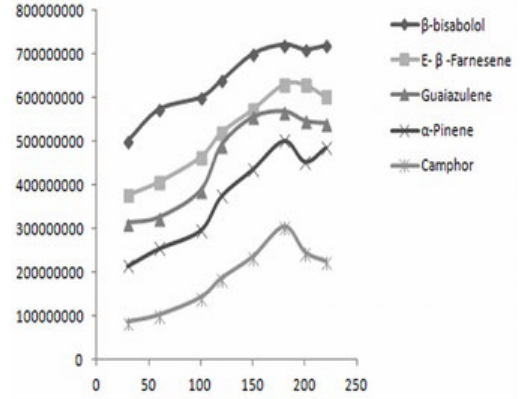
Fig. 5. Effect of desorption temperatures on the extraction efficiency. (X= O C, Y=area peak)